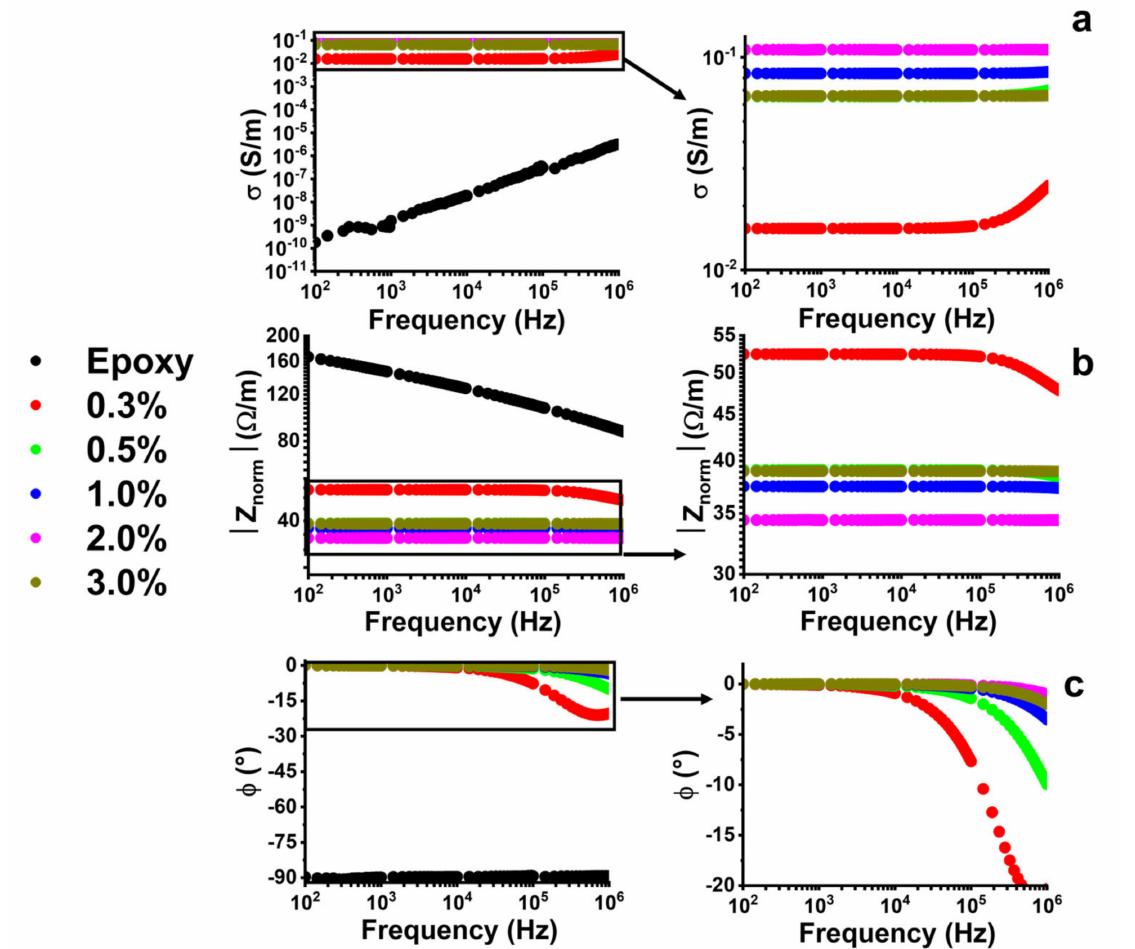
Figure 4. ( a ) AC electrical conductivity, ( b ) modulus, and ( c ) phase impedance of composite materials, evaluated in the frequency range of 100 Hz–1